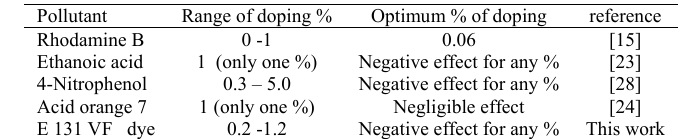
photocatalyst under UV 2